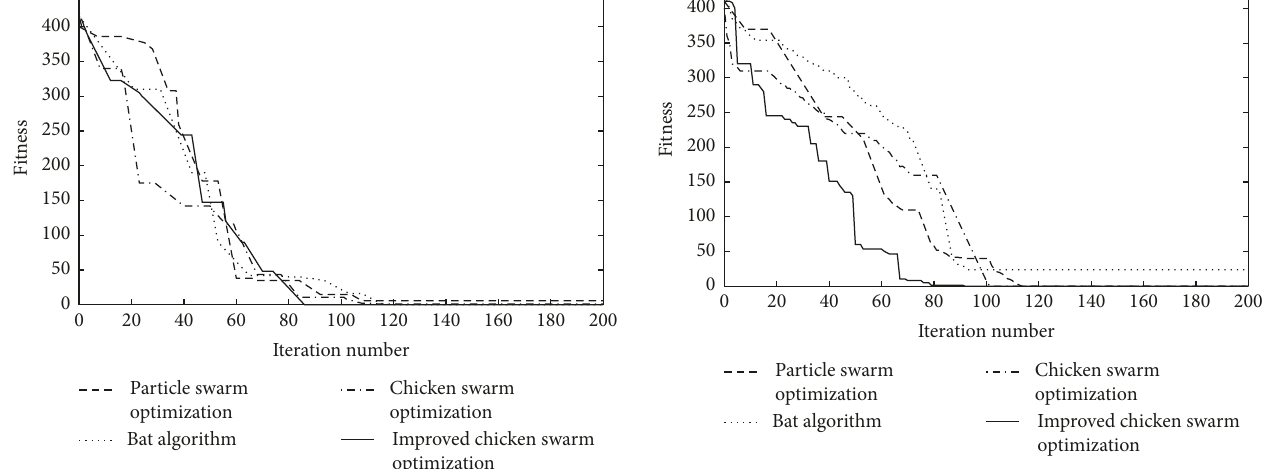
Figure 6: The experimental result of f